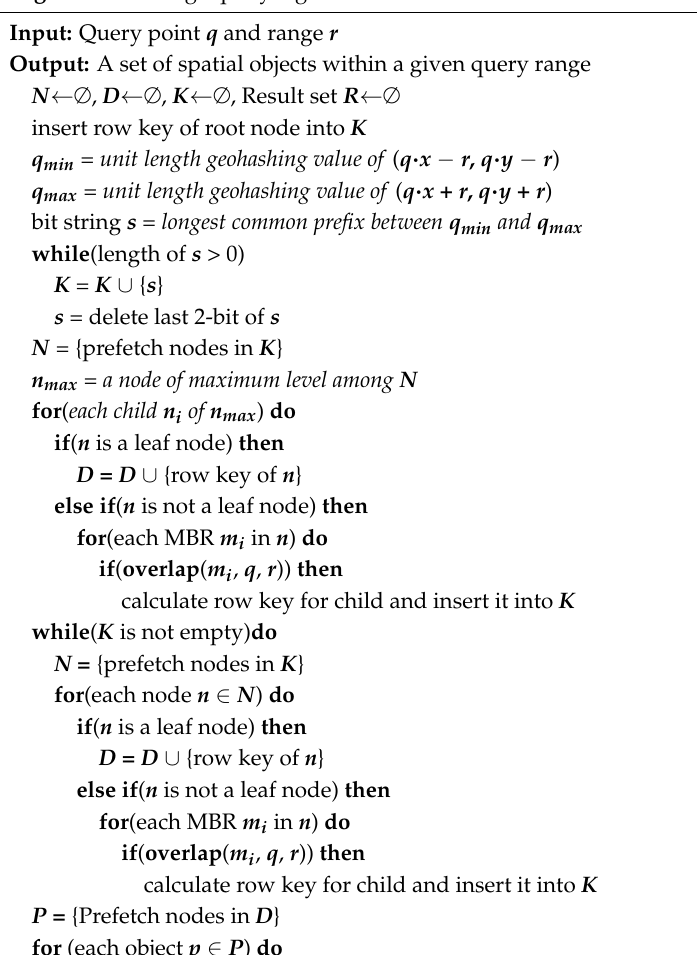
Algorithm 3. Range query algorithm